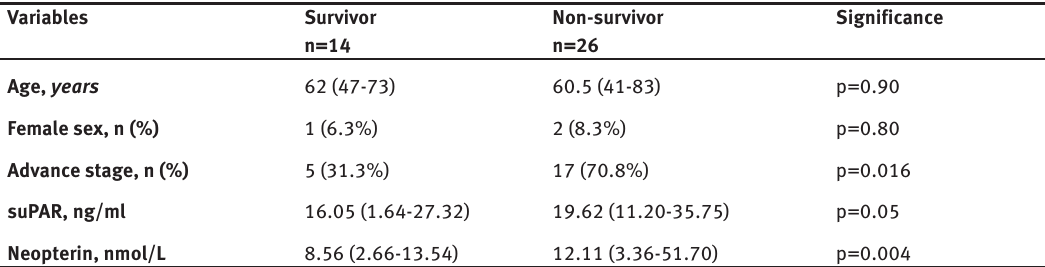
Table 2: The comparison of survivors and non-survivors. Variables